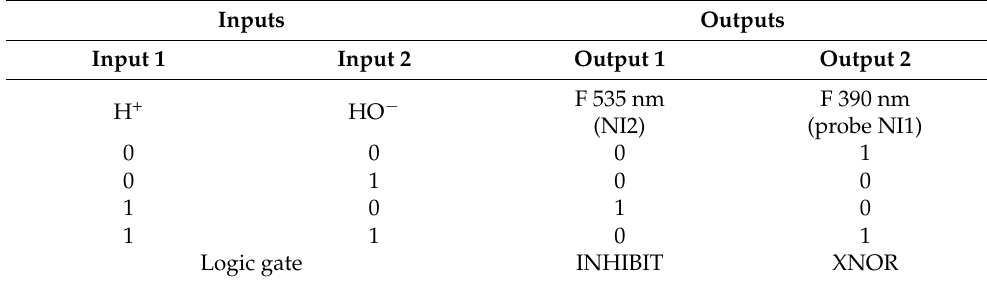
Table 3. The truth table for logic behavior of probes NI1 and NI2 using H + and HO − as inputs.